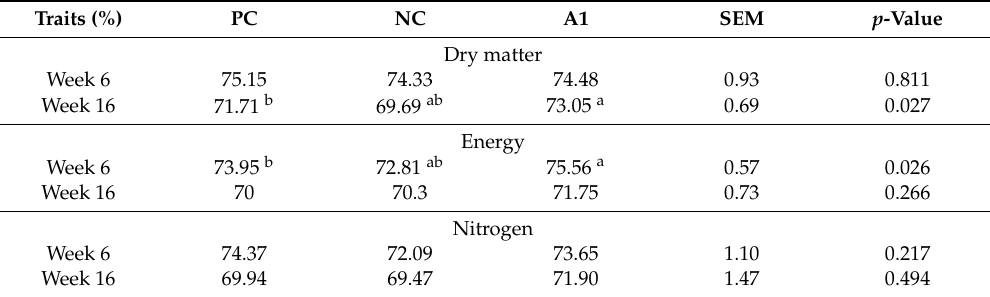
Table 3. E ff ects of dietary supplementation of enzyme blend on apparent total tract digestibility of grower–finisher